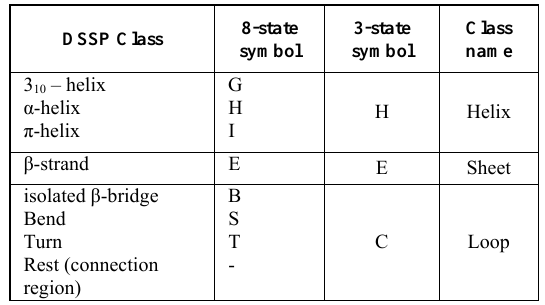
Table 1 8-to-3 state reduction method in secondary structure